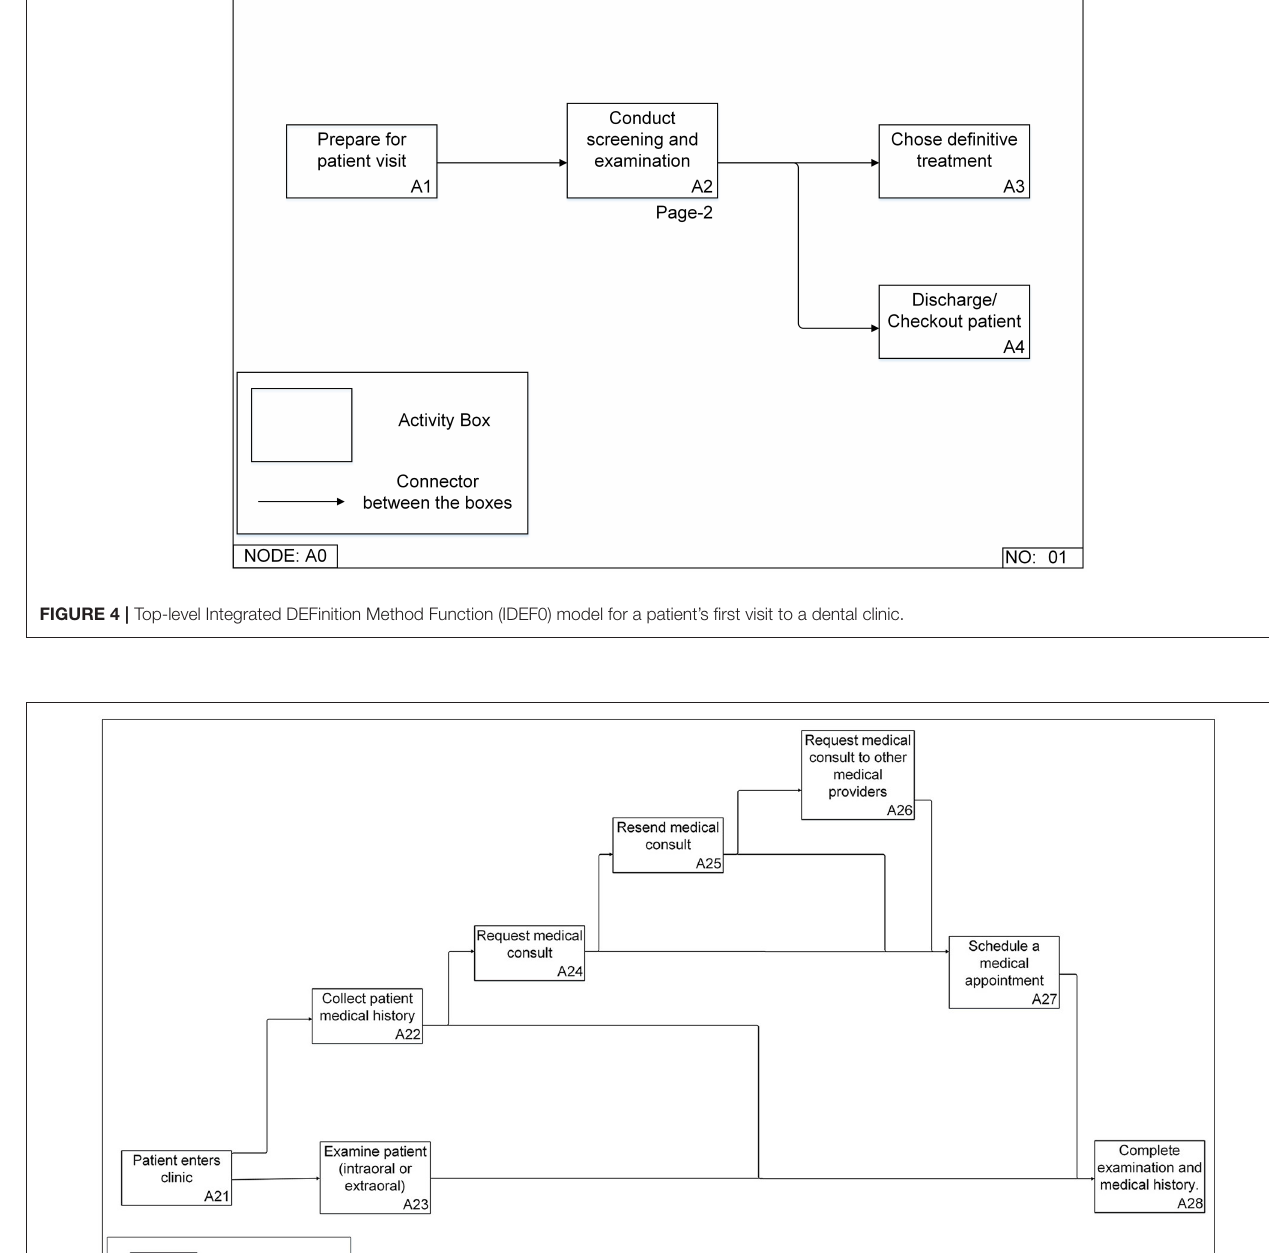
Frontiers in Digital Health |